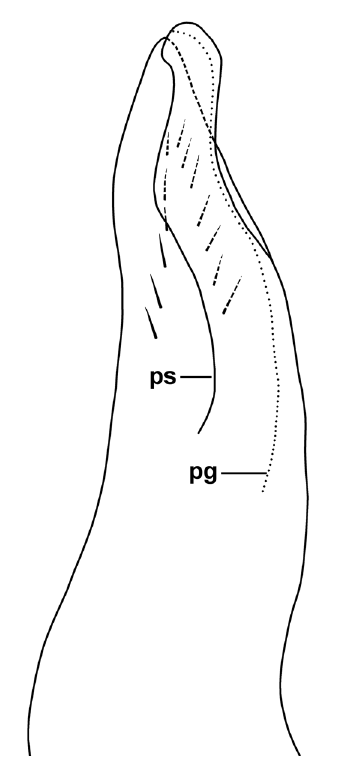
Figure 2. Amastigogonus insularis sp. n., paratype from QVM 2017:23:0047. Right anterior gonopod, medial and slightly posterior view of distal portion of telopodite. pg prostatic groove ps pseudoflagellum. Drawing not to